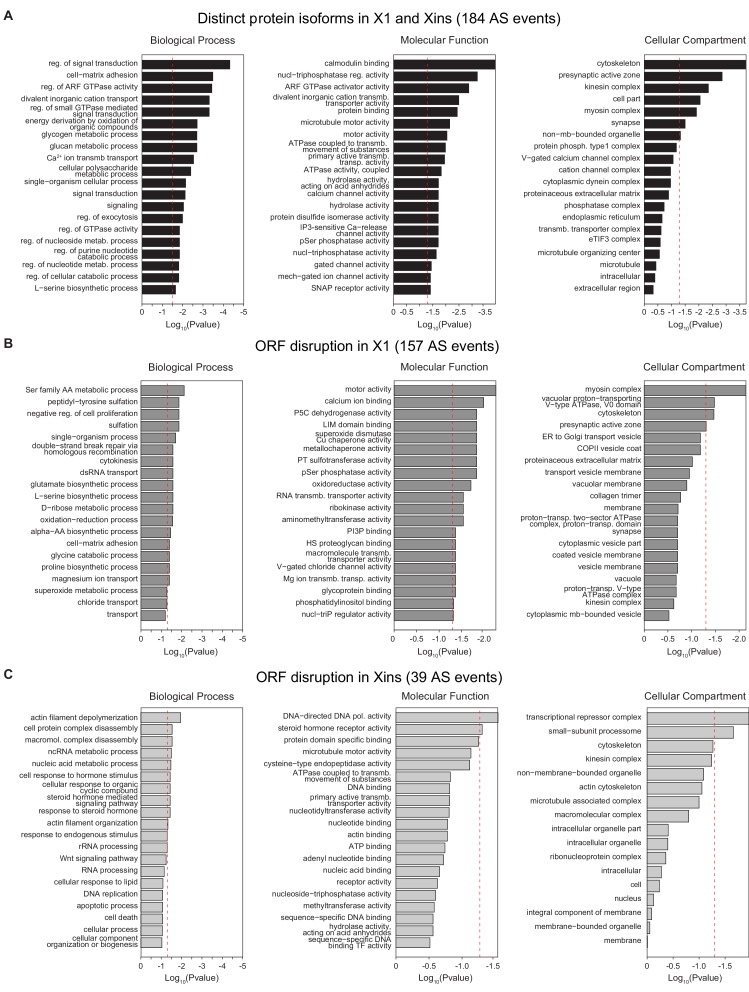
Gene Ontology analysis of X1-differential AS events.(A-C) Gene Ontology analysis of neoblast-differential AS events: Gene ontology enrichment analysis for 'Biological Process', 'Molecular Function' and 'Cellular Component' terms was performed for neoblast-differential events that are predicted to (I) generate distinct protein isoforms in X1 and Xins (black), (J) disrupt ORF in X1 (dark grey), and (K) disrupt ORF in Xins (light grey).